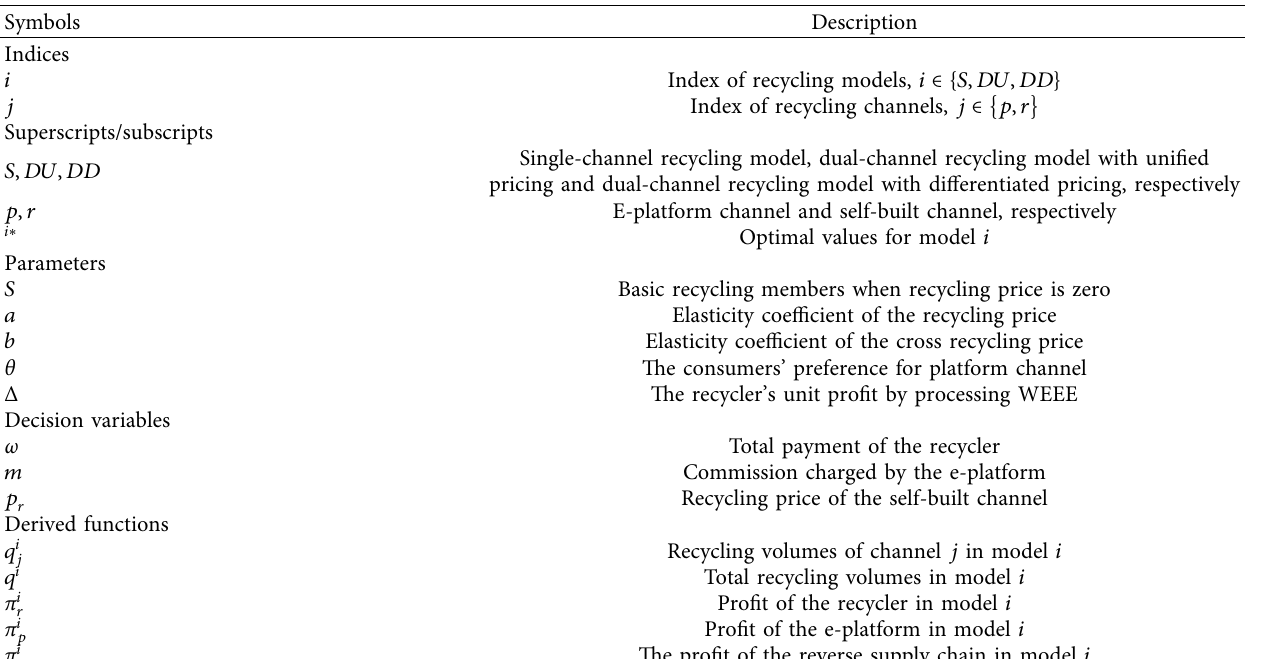
Table 2: Description of the symbols of this article.